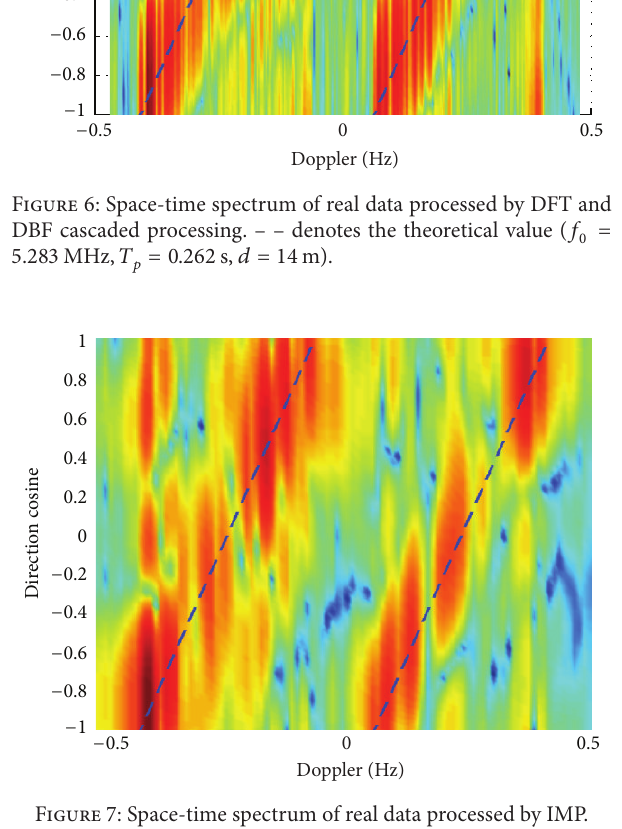
Figure 7: Space-time spectrum of real data processed by